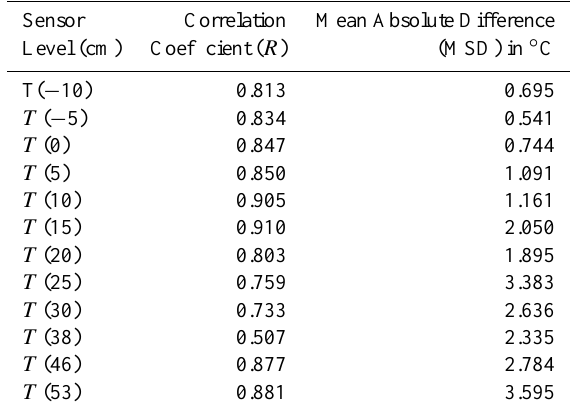
Table 2. Statistical comparison of observed and modeled (SNTHERM) soil and snowpack temperature above and below soil surface.